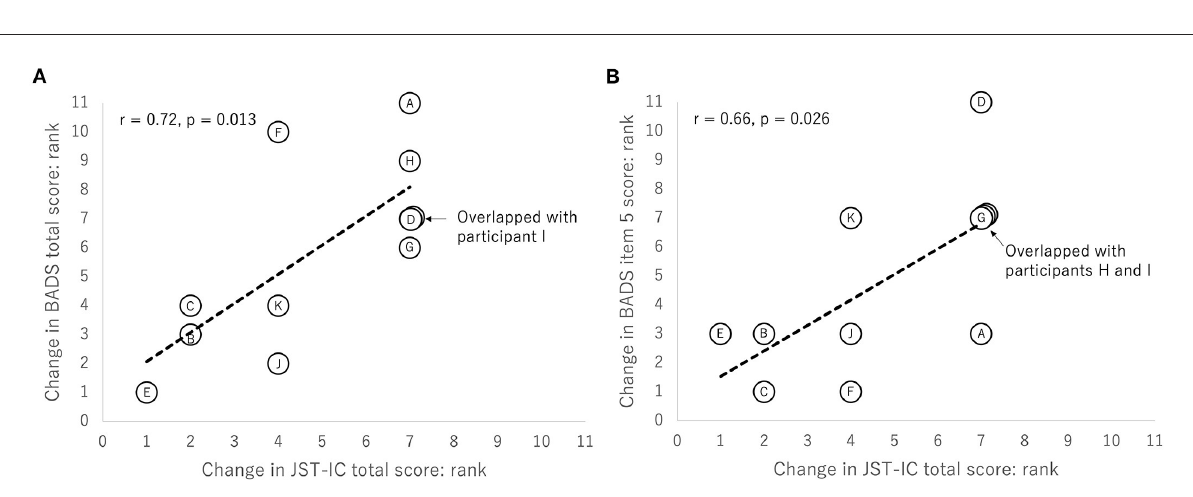
FIGURE3 Scatterplots of (A) changes in JST-IC total score and in BADS total score and (B) changes in JST-IC total score and in BADS item 5 score. All the plots are based on rank. Letters in plots indicate participant